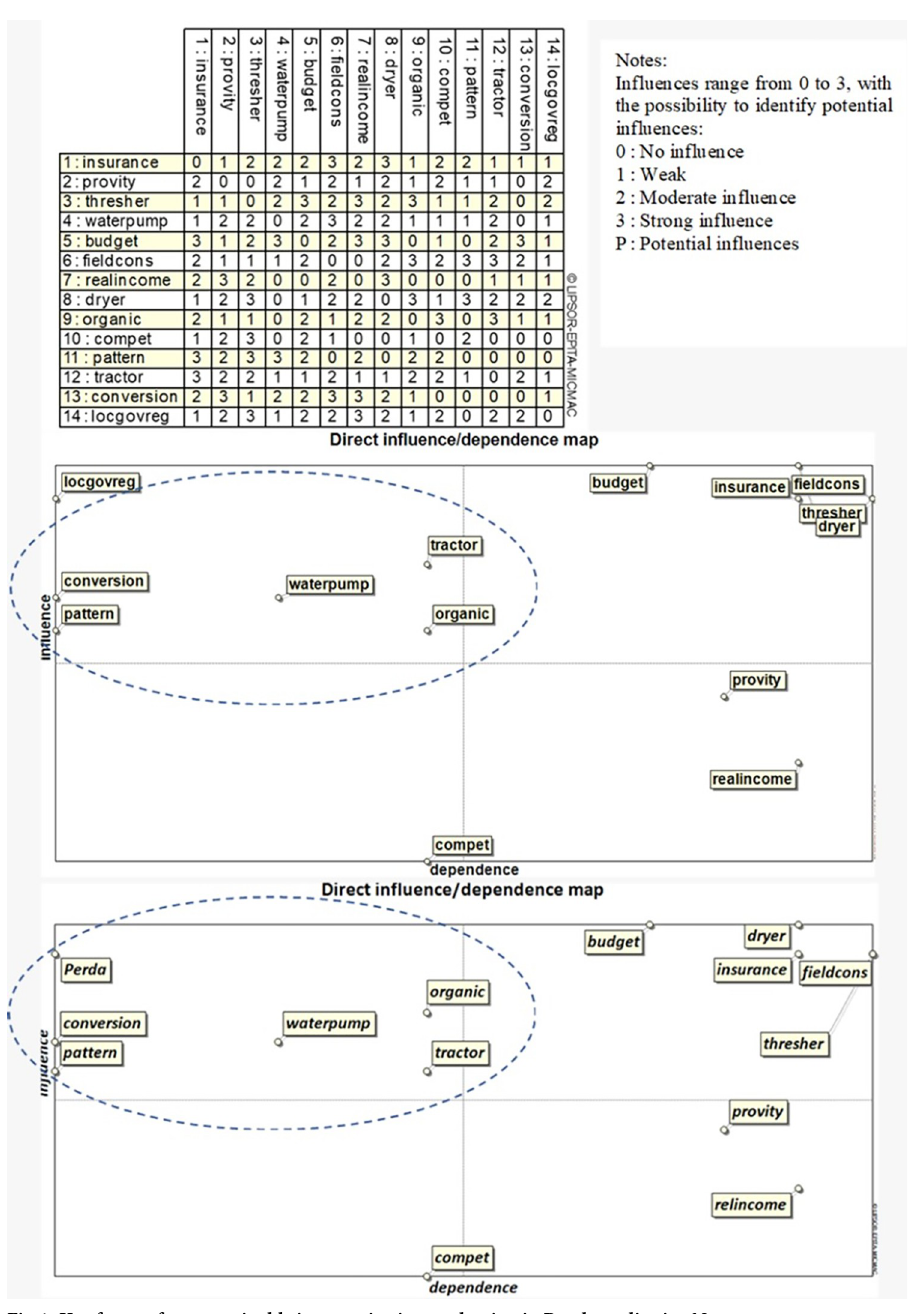
Fig 4. Key factors for a sustainable increase in rice production in Bandung district. Note: